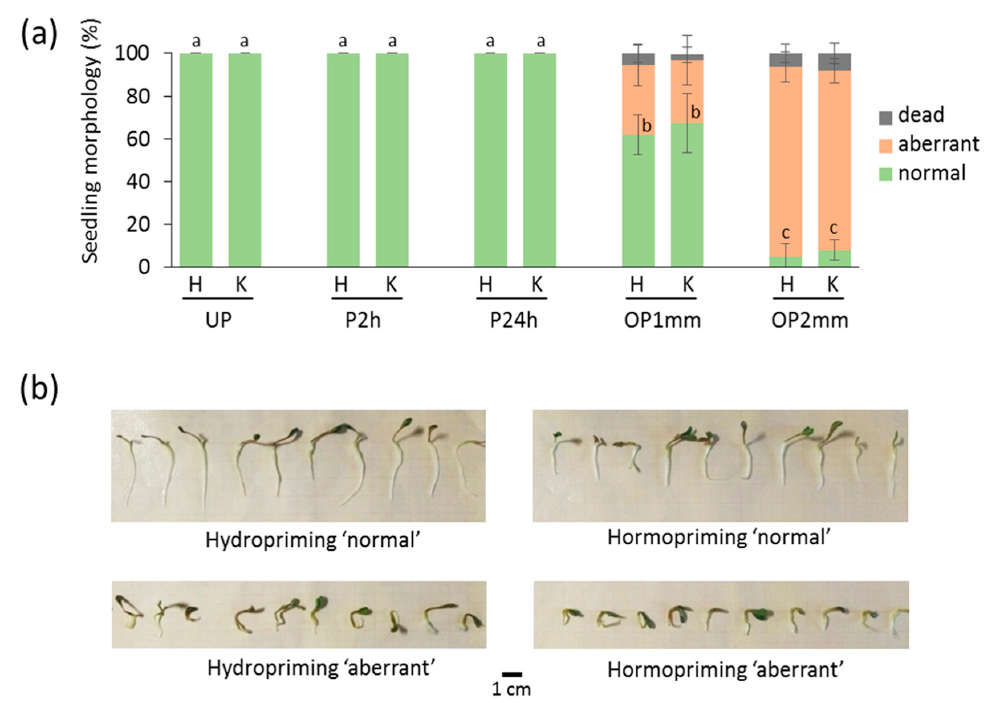
Figure 3. Biometrical analyses of 4-day-old M. truncatula seedlings as a result of imbibition and germination in presence/absence of kinetin and as a result of different hydropriming/hormopriming protocols and overpriming conditions. ( a ) Percentage of the occurrence of ‘normal’, ‘aberrant’ and ‘dead’ seedling morphology. UP, unprimed; P2h, 2 h-priming; P24h, 24 h-priming; OP1mm, over- priming with 1 mm radicle protrusion; OP2mm, overpriming with 2 mm radicle protrusion; H, water; K, kinetin. Means with common superscript letters are not significantly different ( p < 0.05) as analyzed with two-way ANOVA and Tukey test comparing the occurrence of ‘normal’ seedling mor- phology. ( b ) Morphology of ‘normal’ and ‘aberrant’ 4-day-old seedlings developing from prolonged hydropriming and